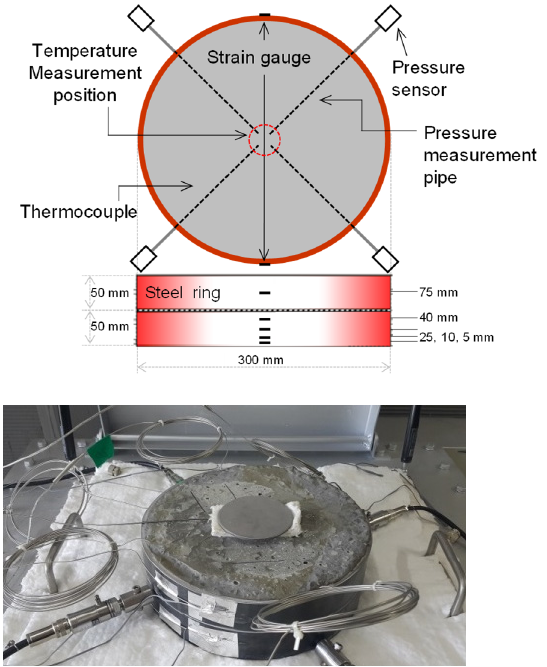
Figure 2. Overview of the ring-restrained concrete